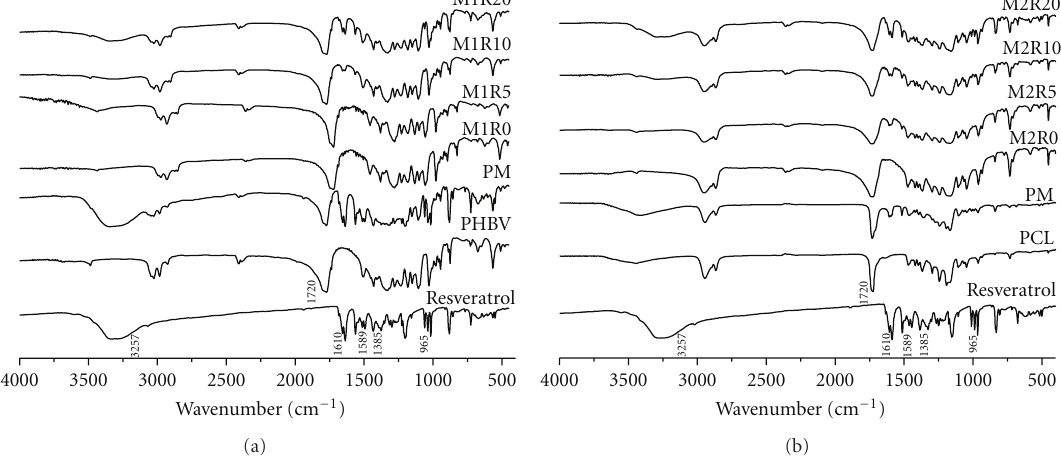
Figure 3: FTIR spectra of resveratrol, PHBV/PCL, physical mixtures, and PHBV/PCL microparticles.